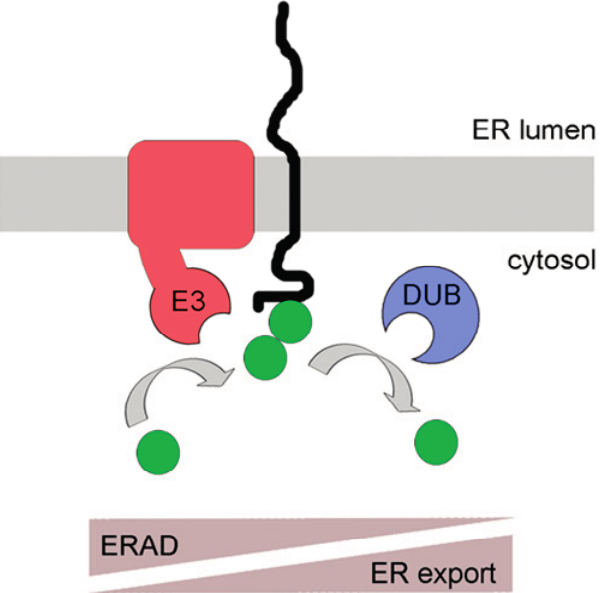
involved in modifying N-glycans on proteins for quality control in the ER lumen [36]. Figure 2. A model for poly-ubiquitin chain (PUC) processing as a mechanism for coupling ER protein quality control with ERAD. Membrane proteins with exposed cytosolic domains are ubiquitinated by E3 ligases. Due to topological confinement of membrane proteins and membrane integrated E3 ligases to the same bilayer, ubiquitination might occur frequently, even on correctly folded proteins. DUBs can remove ubiquitins, favoring ER export of correctly folded species. Reoccurring ubiquitination due to prolonged ER retention as a result of misfolding (in the cytosol or ER lumen) will favor the assembly of PUCs to induce targeting to the proteasome, thereby favoring ERAD. A similar mechanism might occur for soluble proteins prior to their post-translational translocation across the ER membrane, a pathway called prERAD. See text for details. E3 = E3 ligase. DUB = deubiquitinase. Filled green circles: